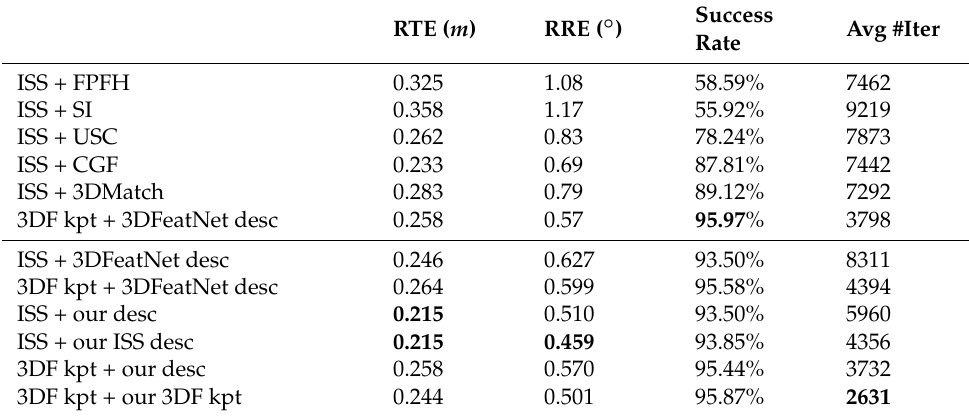
Table 2. Registration Error on the KITTI Dataset.